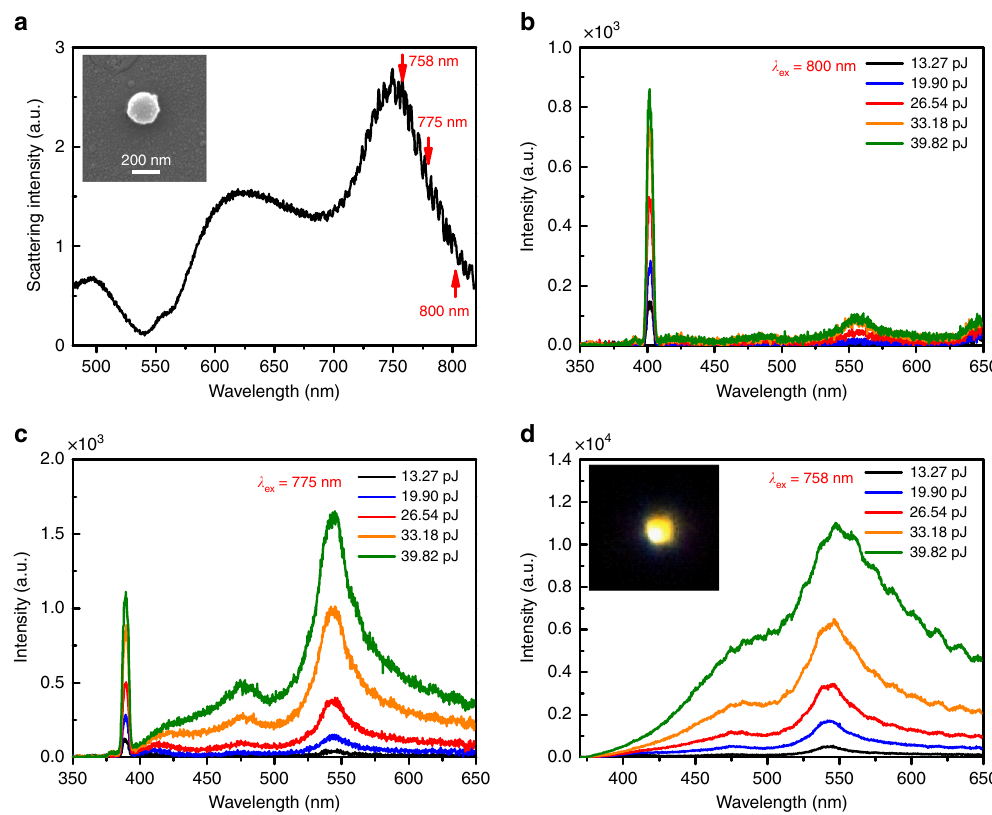
Fig. 2 White-light emission from silicon nanospheres. a Scattering spectra measured for a silicon nanosphere (NS) with d ~192 nm. The inset shows the scanning electron microscope image of the silicon NS. b – d show the dependence of the nonlinear response spectrum of the silicon NS on the excitation pulse energy measured at 800, 775, and 758 nm, respectively. White-light emission recorded by a charge coupled device is shown in the inset of